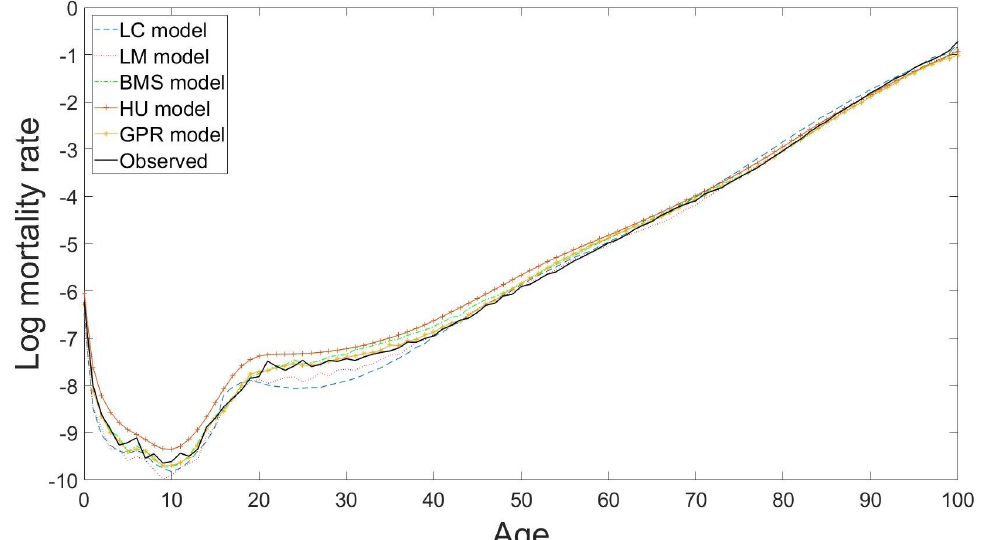
Figure 7. Predicted male mortality curves from age 0 to age 100 for the year 2016 using the LC model (with RMSE = 0.2172), the LM model (with RMSE = 0.1660), the BMS model (with RMSE = 0.1109), the HU model (with RMSE = 0.2342) and the GPR model (with RMSE = 0.0895) based on the observations from the year 1947 to the year 2006 in